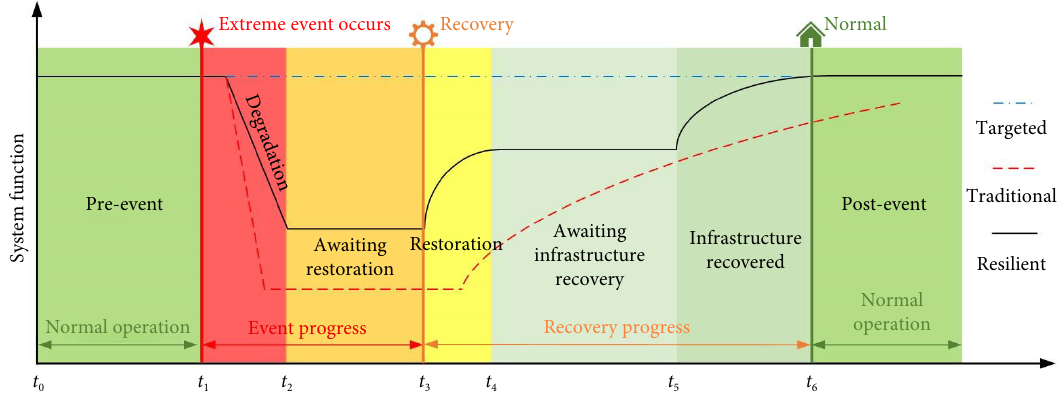
Fig. 4 Typical system function curve of resilient power